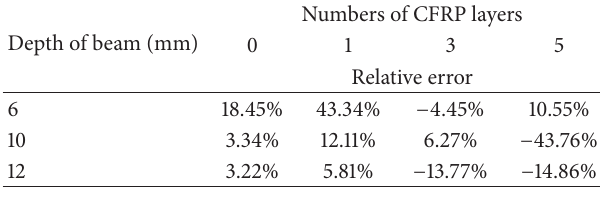
Table 3: Relative error statistics of FEA.